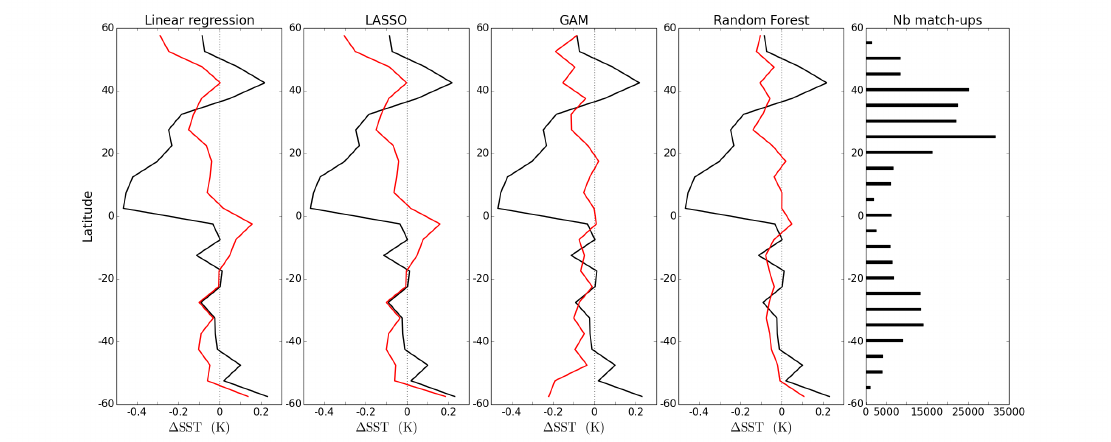
Figure 3. ∆ SST = SST sat − SST buoys (black line) and ∆ (cid:100) SST = SST corr − SST buoys (red line) averaged per latitude bins of 5 ◦ for linear regression, Least Square Shrinkage and Selection Operator (LASSO), Generalised Additive Model (GAM) and random forest models (from left to right) for the test sample. Far right plot shows the number of match-ups for each latitude